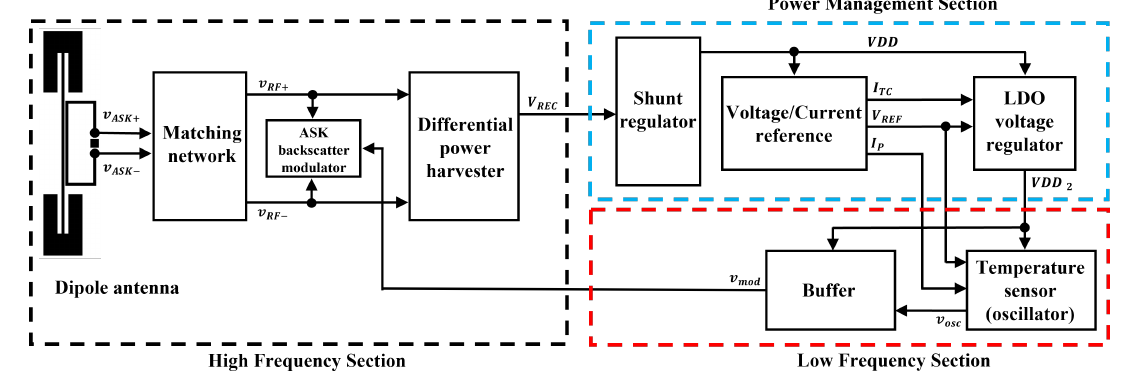
Figure 1. Block diagram of the proposed